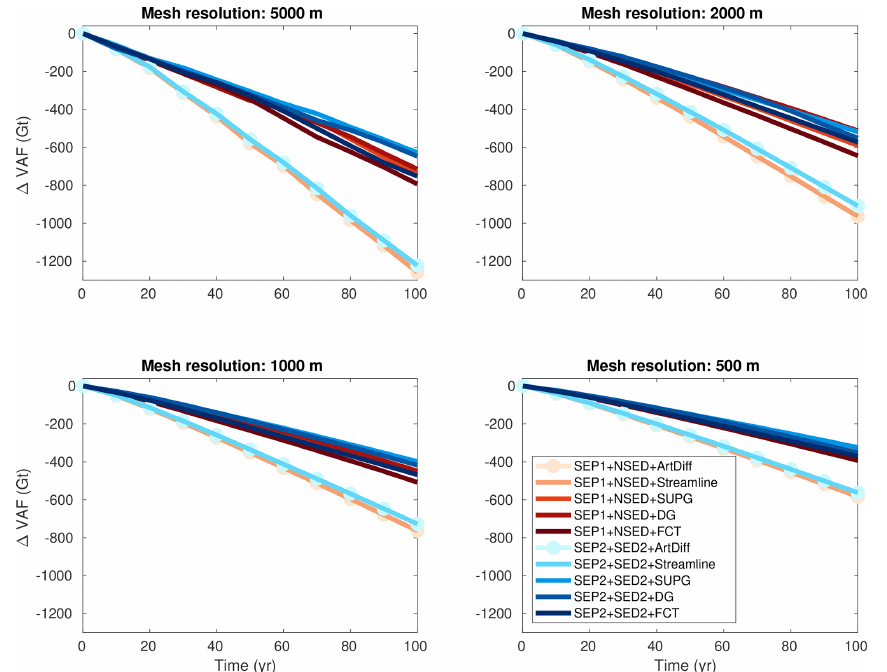
Figure 10. Basal melt experiment (melt on partly floating elements): evolution of (cid:49) VAF for different mesh resolutions and stabilization schemes (see legend). Two sets of sub-element parameterizations are employed: SEP1 + NSED and SEP2 +